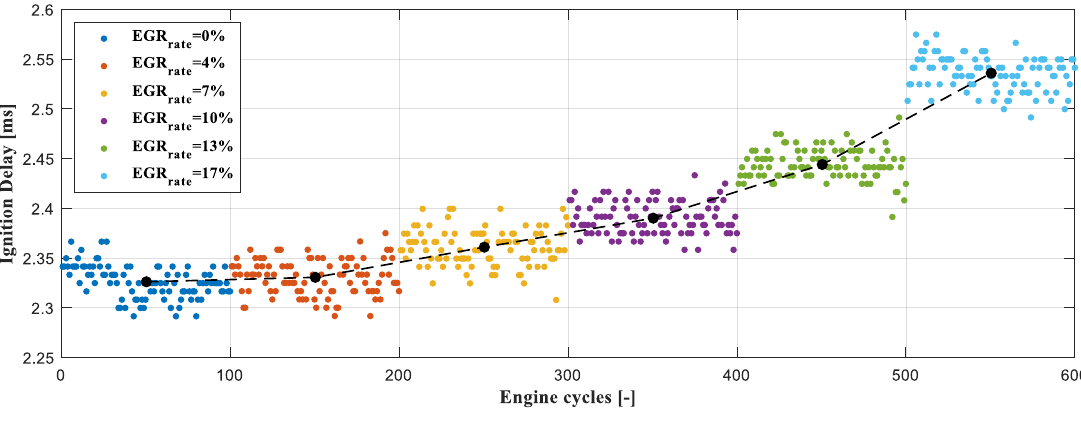
Figure 15. Effect of different EGR rates on ID.